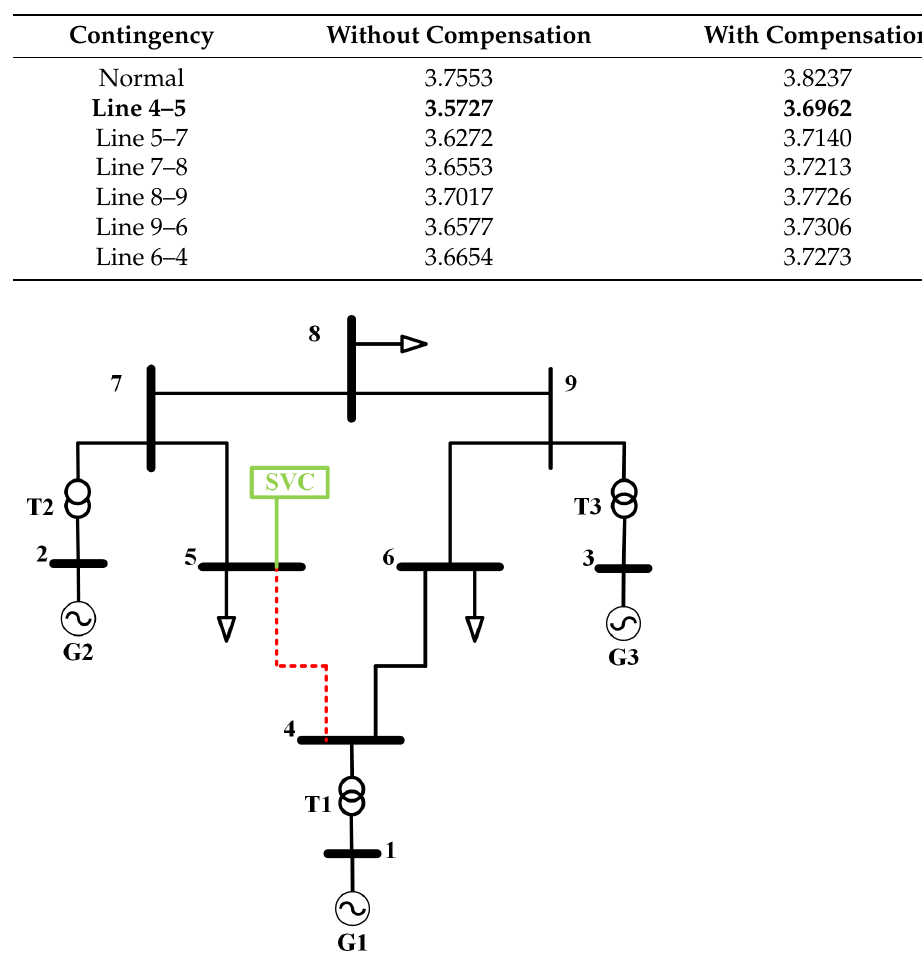
Table 1. Contingency index of the IEEE 9-bus bar model.